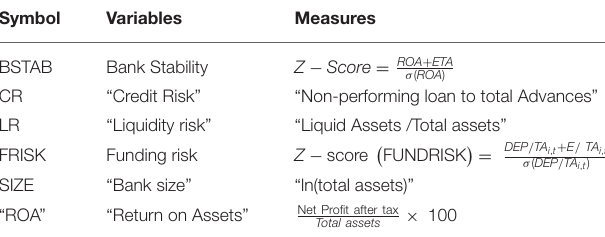
TABLE 1 | Description of